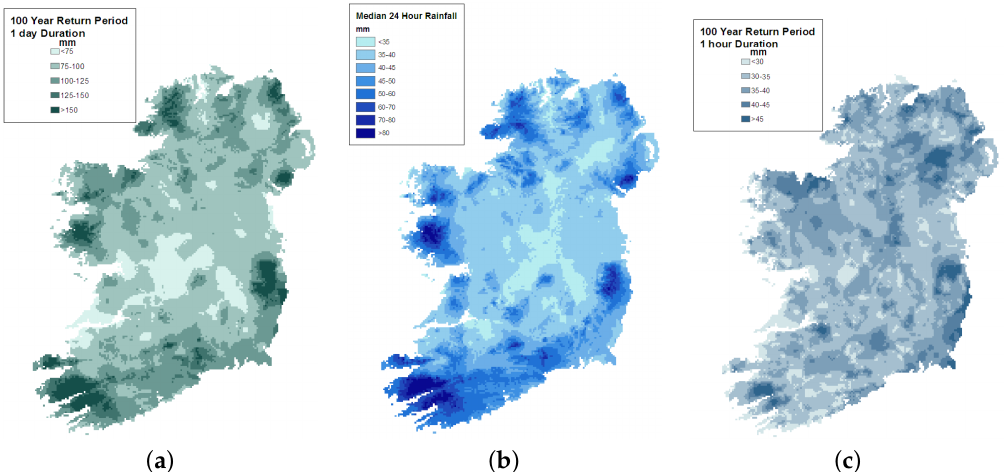
Figure 4. Rainfall return period mapped for ( a ) 100 year return, 1 day duration; ( b ) 1 year return, 1 day duration; ( c ) 100 year return, 1 h duration. Mapped by Fitzgerald for Met Éireann for the island of Ireland. Reprinted from [51].